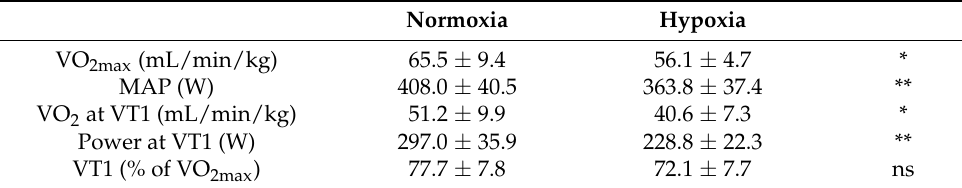
Table 1. Subject characteristics during the maximal incremental test performed in normoxia and in hypoxia.